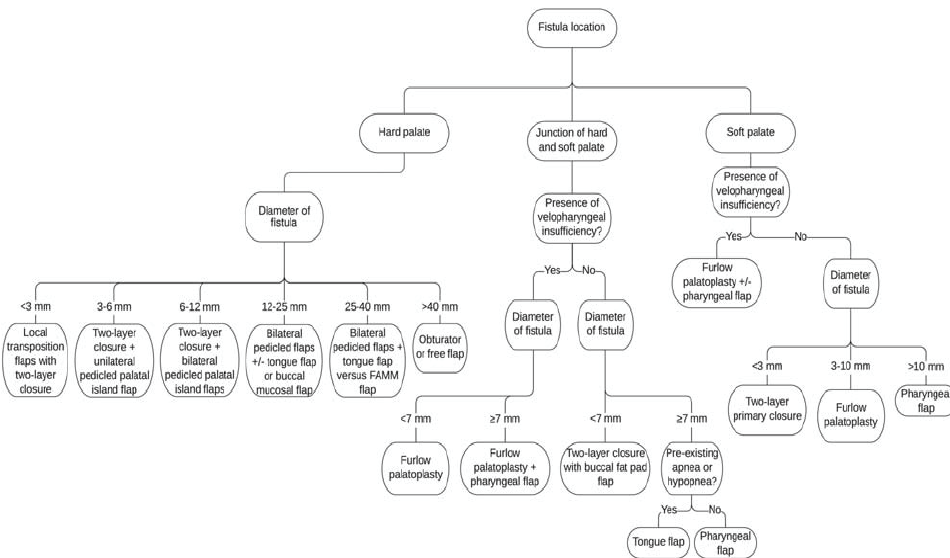
Figure 2. Decision tree on surgical techniques for palatal fistulae (Reprinted with permission from [17]. Copyright 2020, Shirley Hu.)